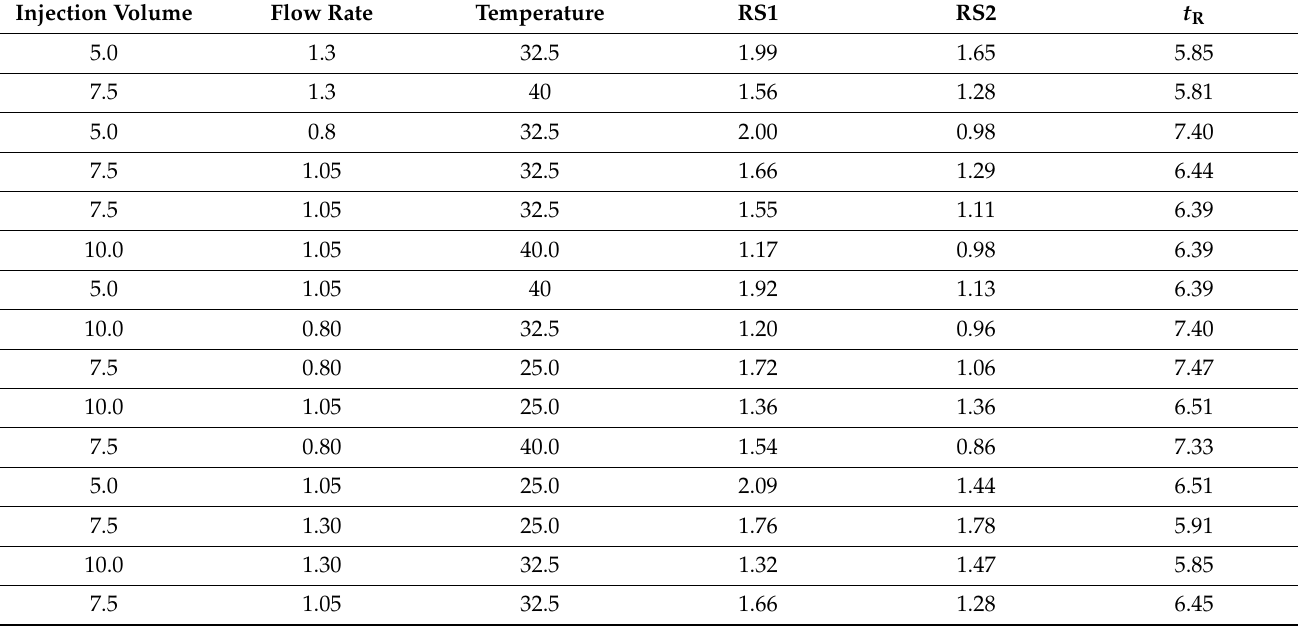
Table 1. Box–Behnken design